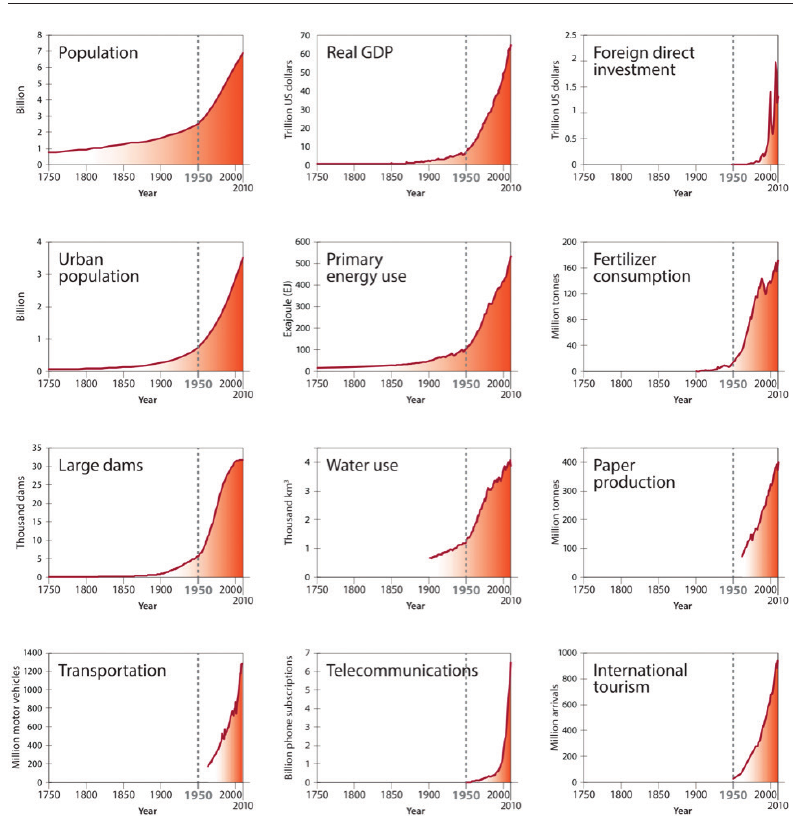
Figure 4: Socio-economic trends. Reproduced by kind permission of Will